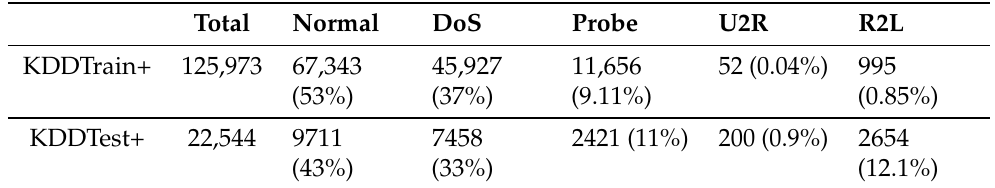
Table 1. NSL-KDD record distribution.